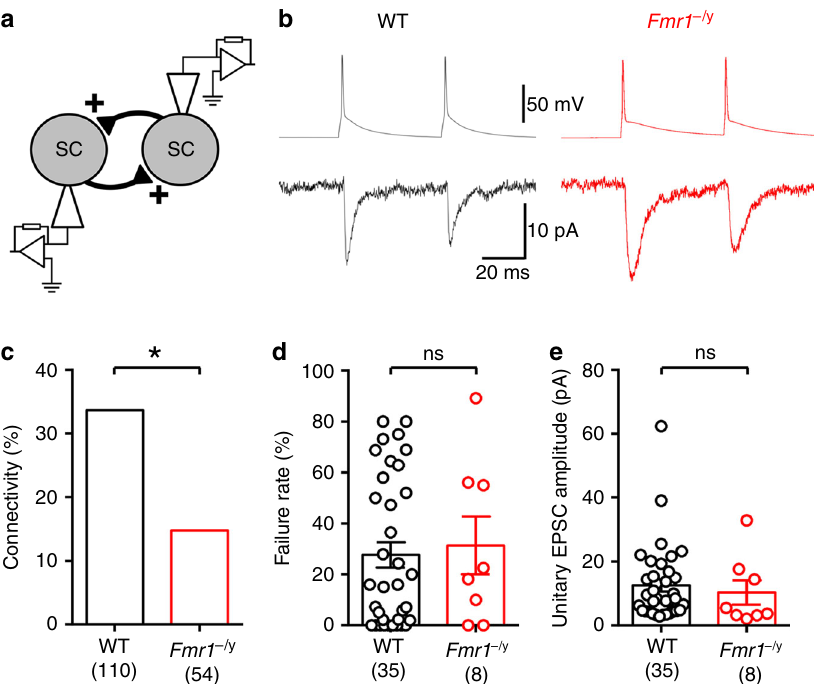
Fig. 2 Typical EPSC amplitude at unitary connections between L4 SCs. a Schematic paired recordings between synaptically coupled L4 SCs. b Representative presynaptic action potentials (top) produced unitary EPSCs in the second L4 SC (lower), from WT (black) and Fmr1 − /y (red) mice. c Synaptic connectivity is reduced between L4 SCs in the Fmr1 − /y mouse (d.f.: 162; p = 0.015; Fisher ’ s exact test; 110 pairs from 13 mice for WT mice and 54 pairs from 7 mice in Fmr1 − /y mice were tested. d Failure rate was not different between genotypes when a connection was present. e Unitary EPSC amplitudes from L4 SC synapses were not different between genotypes. Statistics shown: ns p > 0.05, * p < 0.05 from Fisher ’ s exact test ( c ) and LMM ( d , e ). All data are shown as mean ± SEM and source data for all plots are provided as a Source Data fi